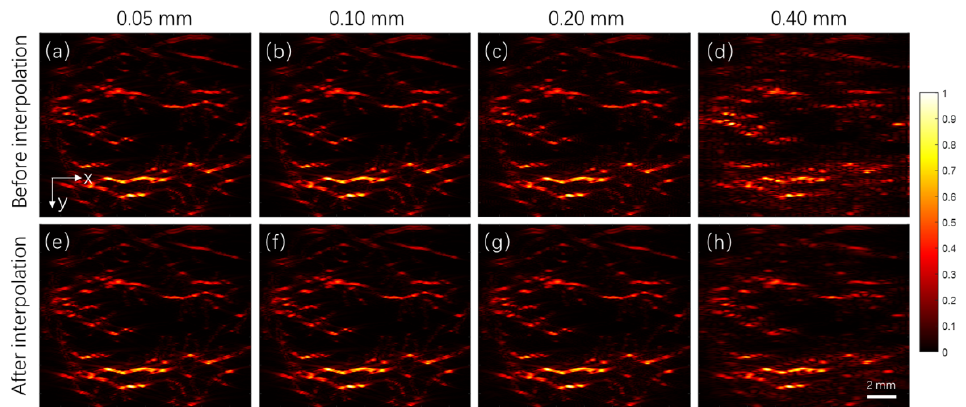
Figure 7. The influences of scanning step size and data interpolation on the reconstruction results. ( a – d ) The reconstruction results with the STR-BP method when the step size are 0.05 mm, 0.1 mm, 0.2 mm, and 0.4 mm, respectively, and ( e – h ) the corresponding reconstruction results of ( a – d ) when the forward data is interpolated to keep the step size back to 0.05 mm.